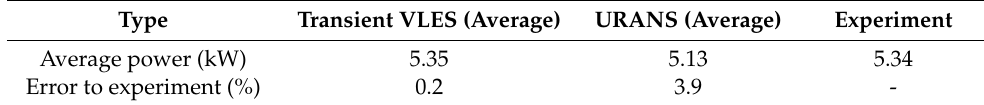
Table 8. Comparison of CFD power values with experimental data (wind speed = 15 m/s)